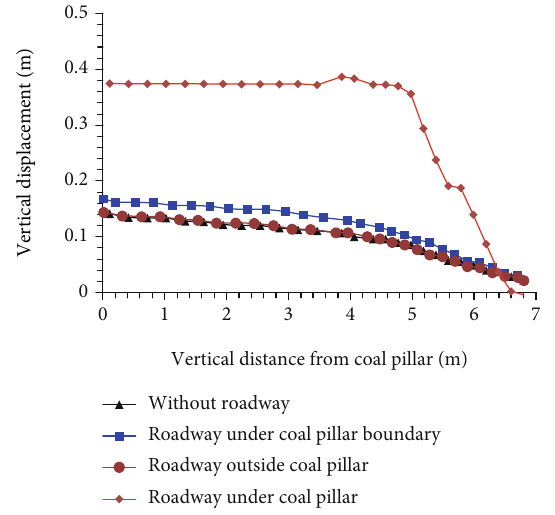
Figure 13: Subsidence curve of coal pillar fl oor (Figure 4(b)), internal staggered roadway (Figure 12(b)), verti- cal roadway (Figure 12(a)), and external staggered roadway (Figure 11(a)). The subsidence is large, and the main bearing